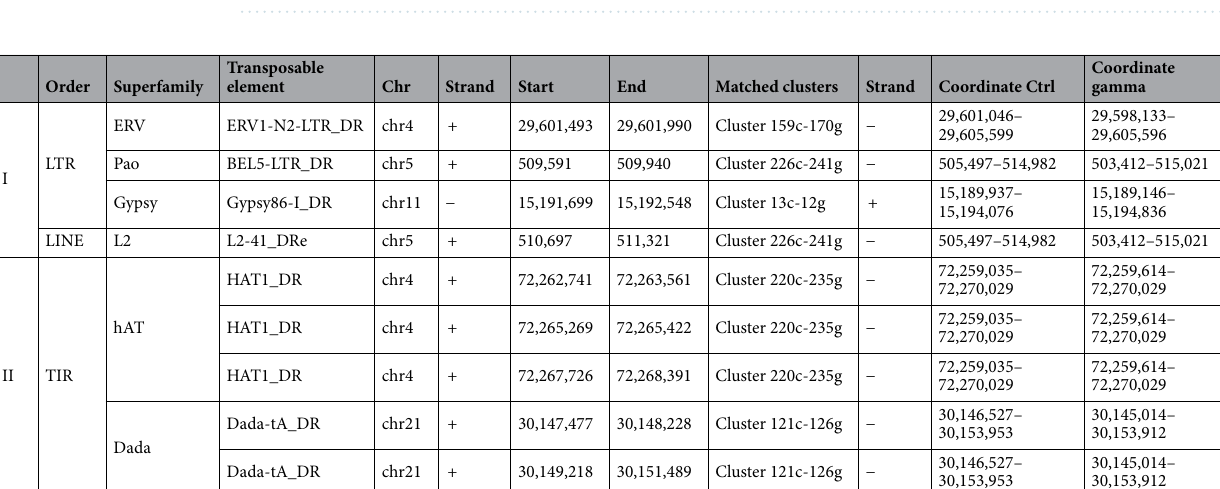
Figure 6. Analysis of piRNA signatures in clusters predicted in F 1 generation of embryos (5.5 hpf) from parents exposed to 8.7 mGy/h γ-radiation (F 1 -γ) and non-exposed control parents (F 1 -C) (n = 3). A) Read length distribution. B) Per base distribution analysis. C) 5 ′ 10nt overlap distribution. Asterisk indicates significant differences (p < 0.05; paired t test). D) Read length analysis of reads with 5 ′ 10nt overlapping (ping-pong